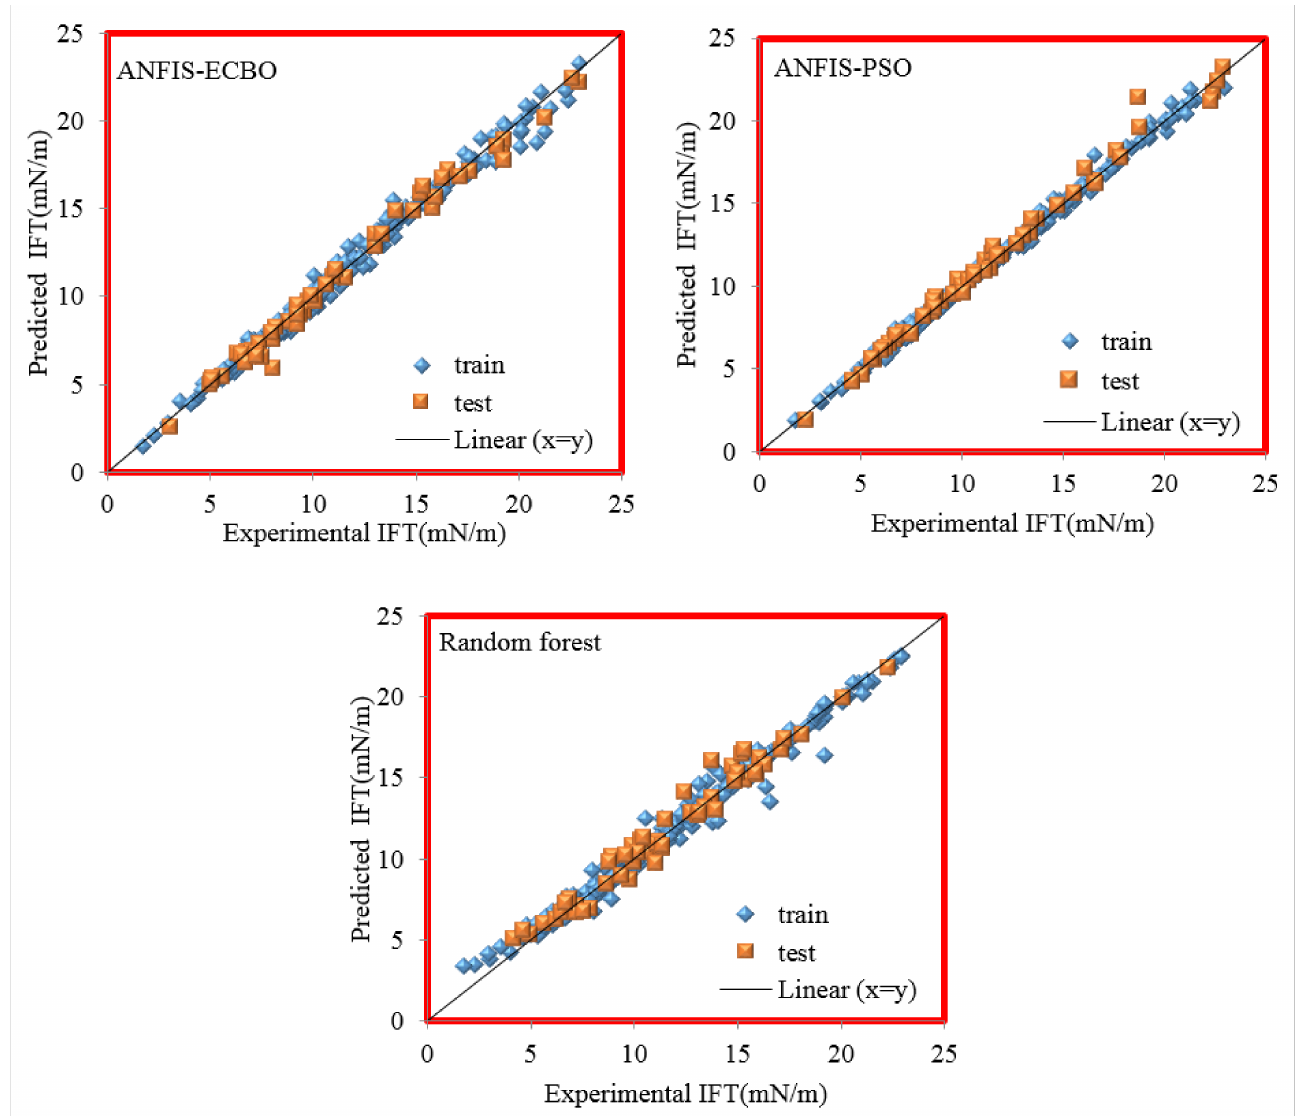
Figure 6. Cross plots of all proposed